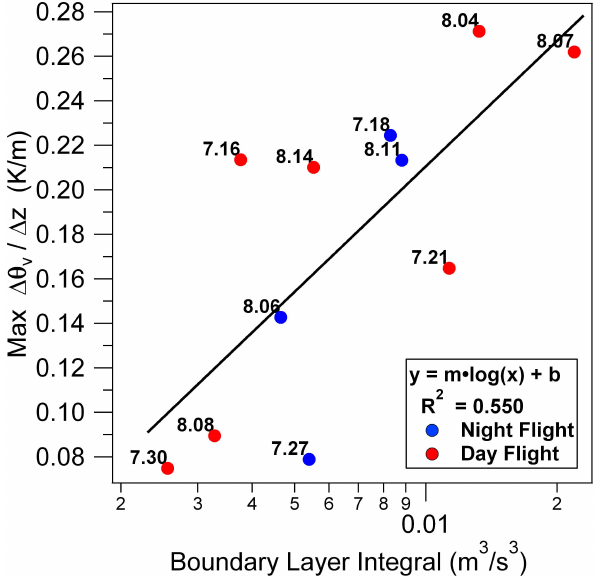
Fig. 11. Scatter plot of the entrainment integral (i.e. R − F b from Eq. 6) versus the maximum θ v gradient, which is a measure of the stable stratification of the air in the cloud top region. Each point is the average value for the flight, with the corresponding date beside each point, and color denoting day and night flights.